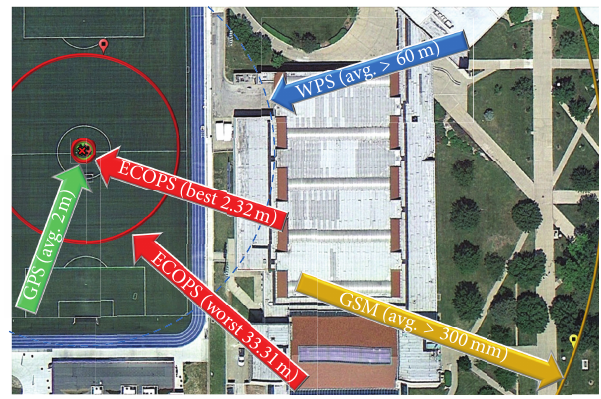
Figure 17: Accuracy comparison: ECOPS, GPS, WPS, and GSM- based